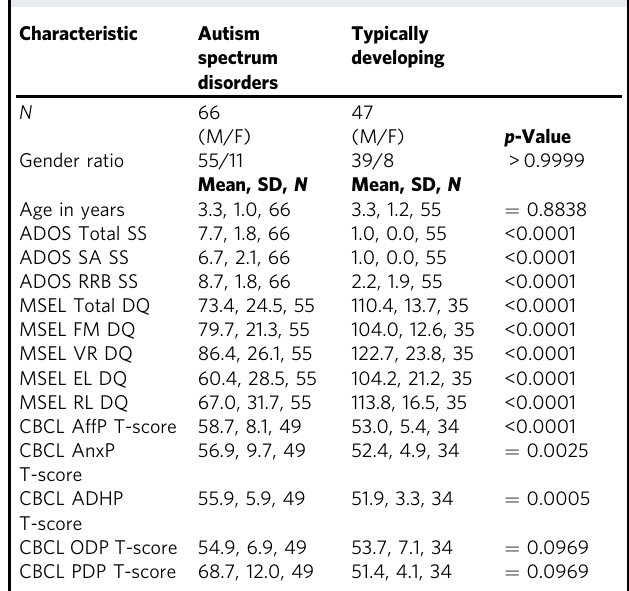
Table 2 Characteristics of study